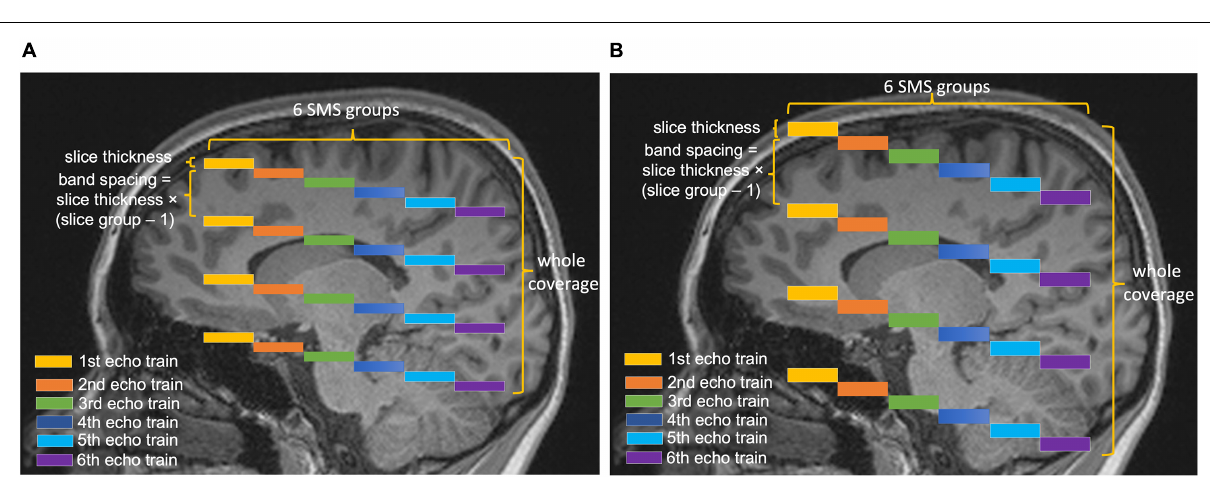
FIGURE 2 | Diagram of the SMS scheme. Six slice groups with a total slice number of 24 are acquired in each TR. The band spacing is adjusted according to the slice thickness to avoid slice cross talk. The center is aligned in different conditions, so that the slice thickness of (A) 4 mm and (B) 8 mm will have different coverages in the slice